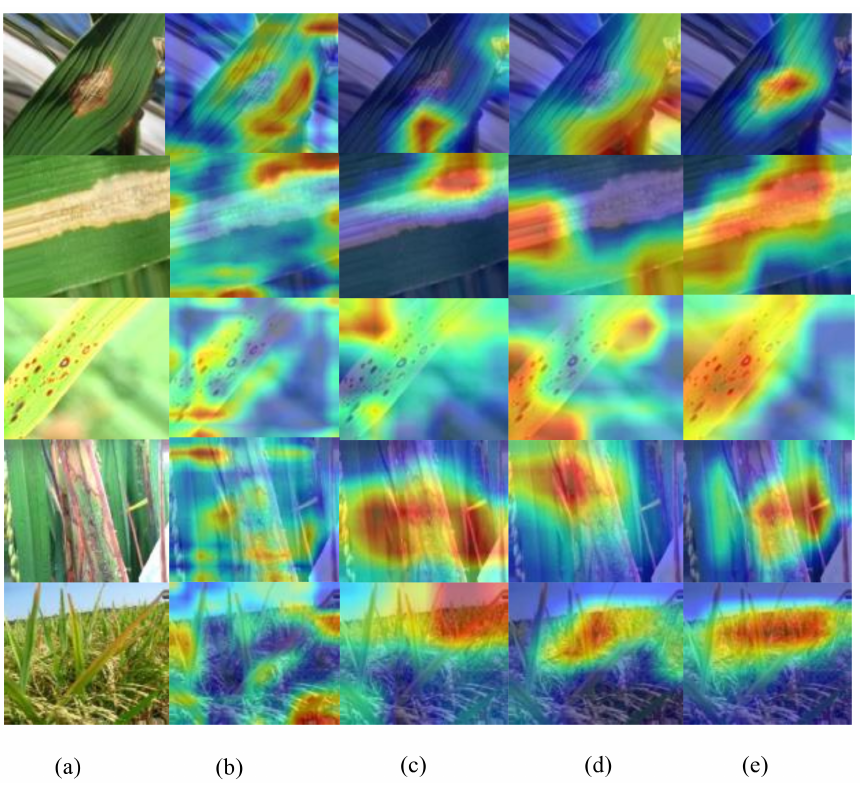
Figure 11. Class activation heatmap of different models: ( a ) original image ( b ) VGG; ( c ) DenseNet; ( d ) ResNet; and ( e )